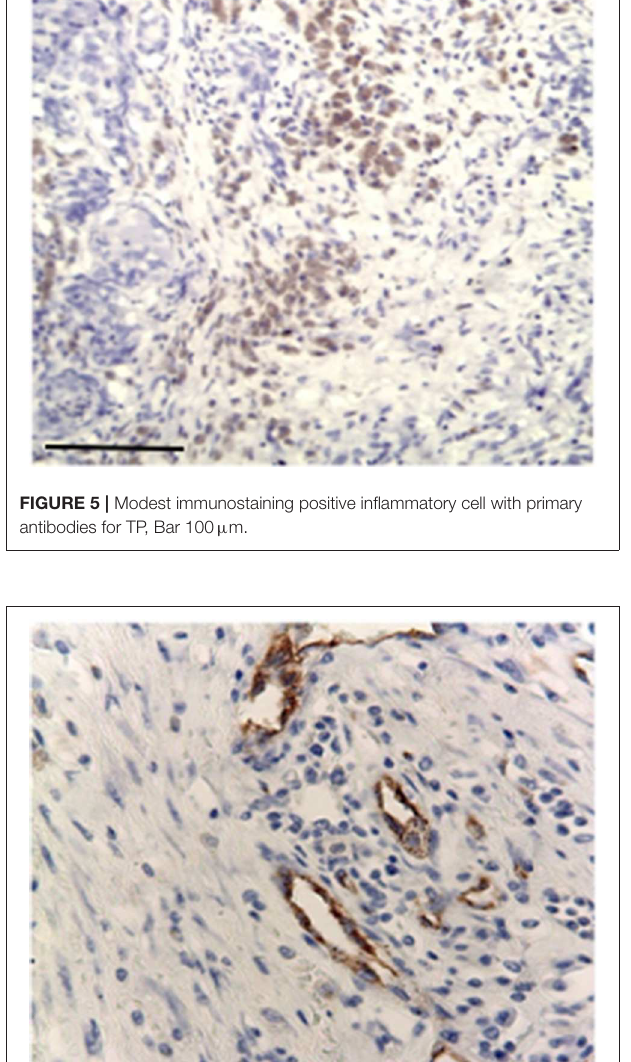
immunohistochemical reactivity was detected in the cytoplasm of tumor cells of the neoplastic mammary epithelial cells ( Figure 2 ). Nucleus was also immunostained but at lower intensity. According to the intensity of the cytoplasmic reaction, the classification system adopted showed a range from 0 to 3, which includes positives TP cells (from 2 to 3).